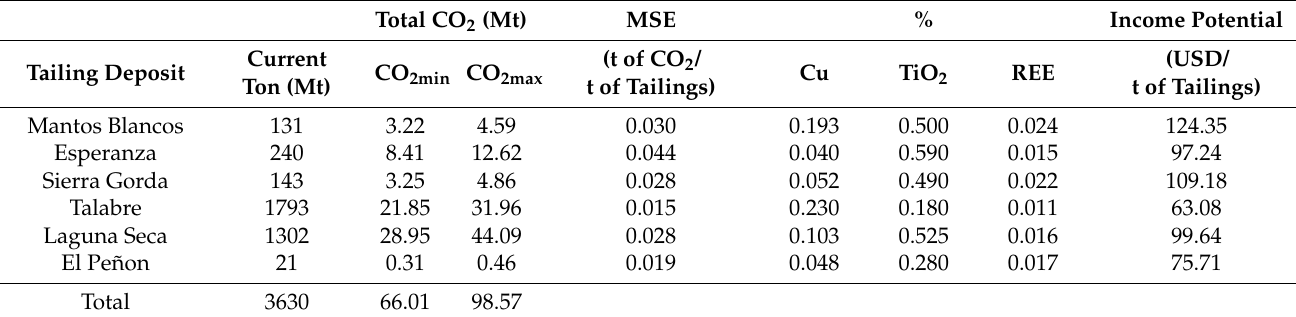
Table 5. Potential of mass of CO 2 to be sequester and mean sequestration efficiency (MSE) with tailing deposits of the Antofagasta region.